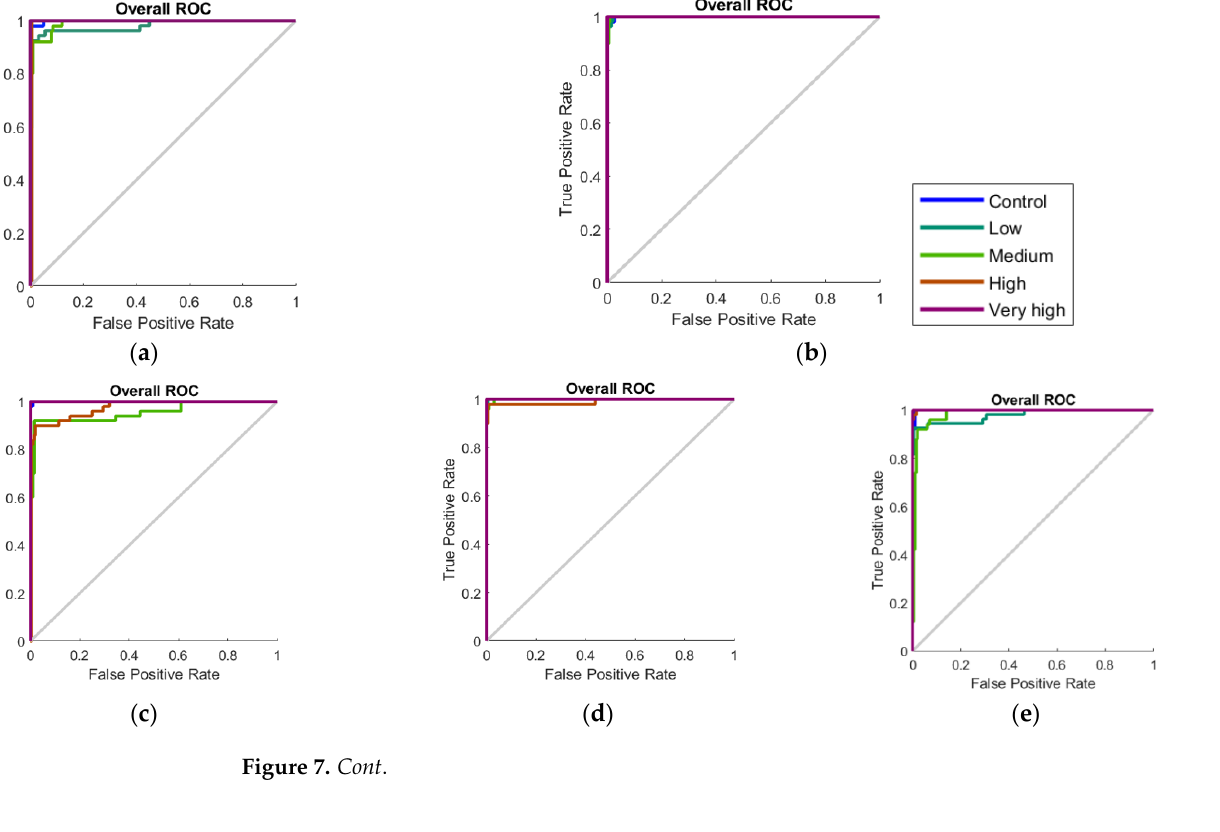
( g ) Figure 7. Overall receiver operating characteristic plot for the pattern recognition models of the glasshouse pathogenicity bioassay (models 5 – 9, a – e , respectively) and the parallel soil experiment (models 10 and 11, f and g , respectively). 4. Discussion 4.1. Physiological Response of Tomato Plants to F. oxysporum Infection The reduction in plant physiological parameters may have resulted from water and nutrient deficits due to roots being infected by Fusarium oxysporum [32 – 35]. Since the